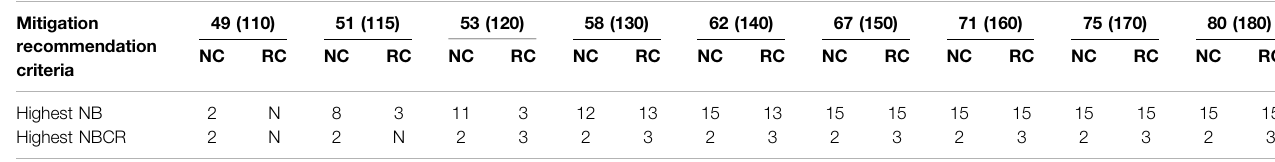
TABLE 5 | Mitigation recommendation (mitigation strategy number) by wind contour, m/s (mph), for new construction (NC) and retro fi t construction (RC) based on the highest net bene fi t (NB) and the highest net bene fi t cost ratio (NBCR). Mitigation recommendation